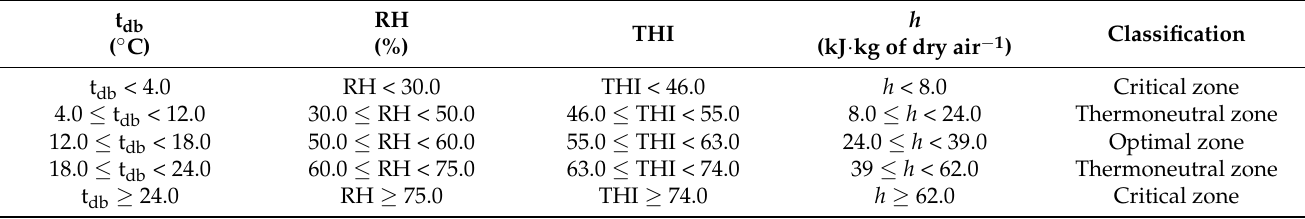
Table 1. Thermal comfort classification for lactating Holstein